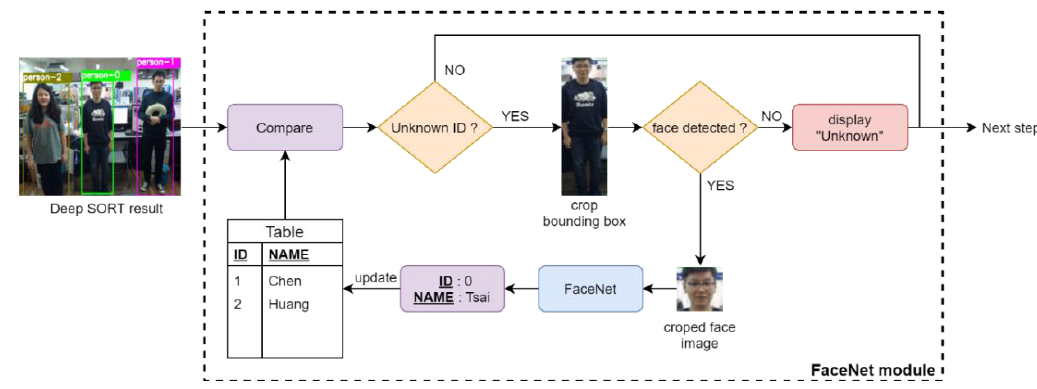
Figure 2. Flow chart of face recognition via FaceNet.